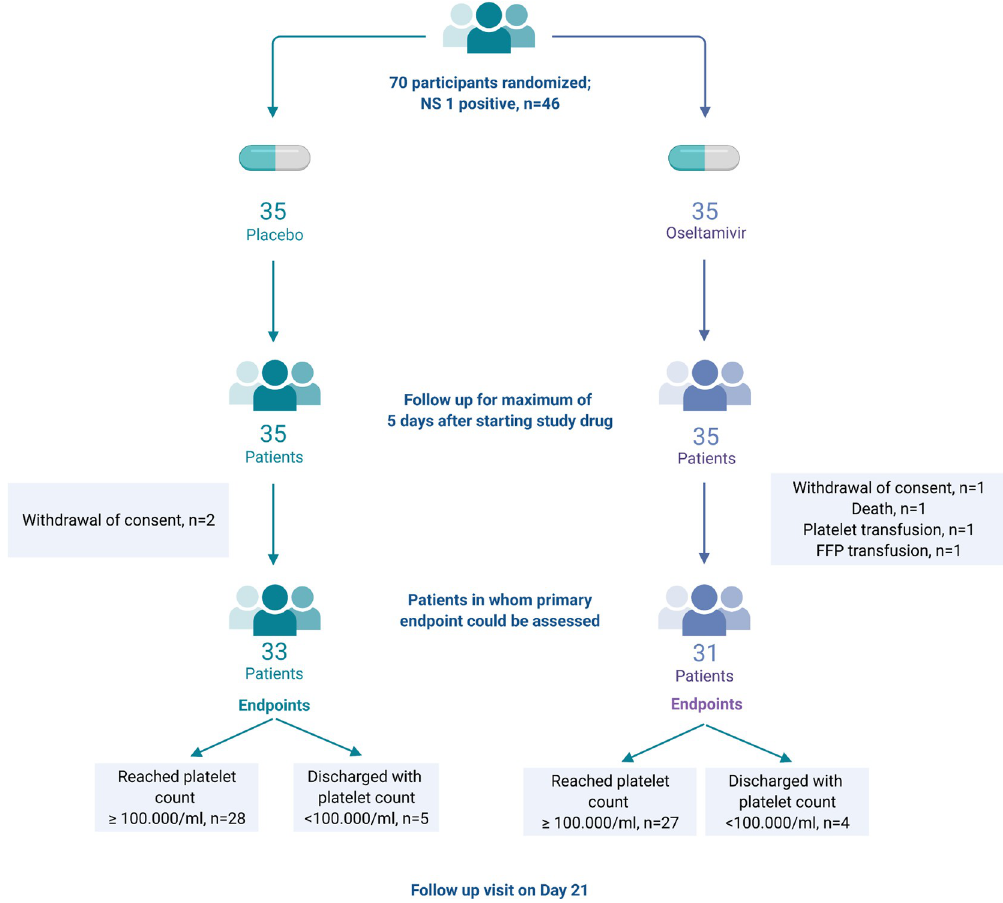
Fig 1. Study flow chart.